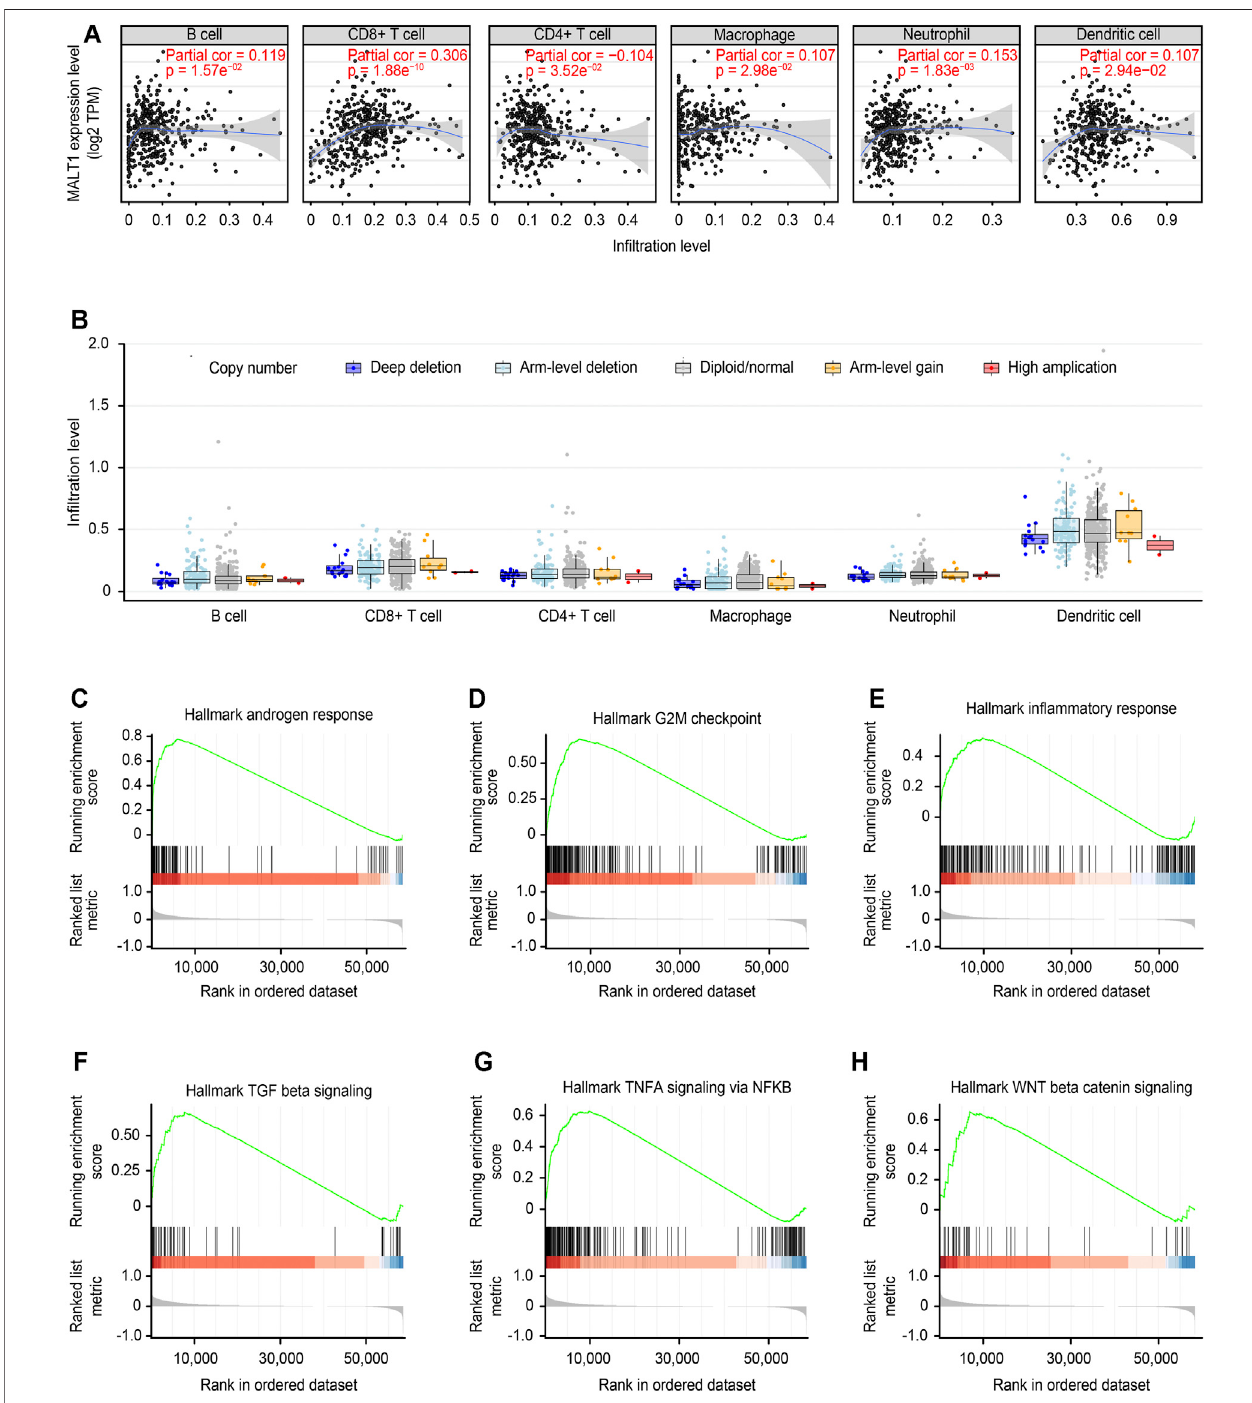
FIGURE 8 | Immune correlation of MALT1 in PCa and GSEA of MALT1. (A) T Correlation of MALT1 expression level with immune in fi ltration level (B cells, CD4 + T cells, CD8 + T cells, neutrophils, macrophages, and dendritic cells) in PCa, as calculated by TIMER with data from the TCGA database. (B) Comparison of tumor in fi ltration levels among tumors with different somatic copy number alterations (SCNAs) for MATL1. SCNAs were de fi ned by GISTIC 2.0, including deep deletion ( − 2), arm-leveldeletion( − 1), diploid/normal (0), arm-level gain(1), and high ampli fi cation (2). Box plots arepresented toshow the distributions of each immunesubset at each copy number status in selected cancer types. The in fi ltration level for each SCNA category was compared with the normal using a two-sided Wilcoxon rank-sum test; (C – H) Gene set enrichment analysis (GSEA) for the expression level of MALT1 and the signal pathways activated were present.